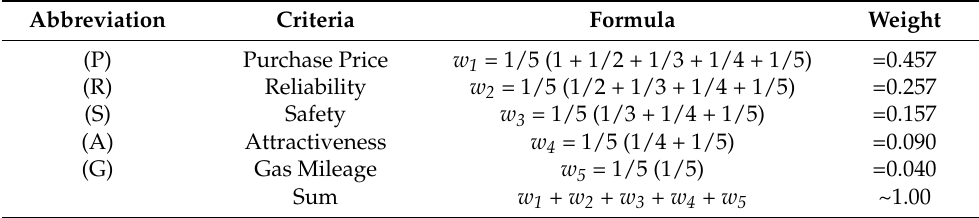
Table 13. Weight using ROC